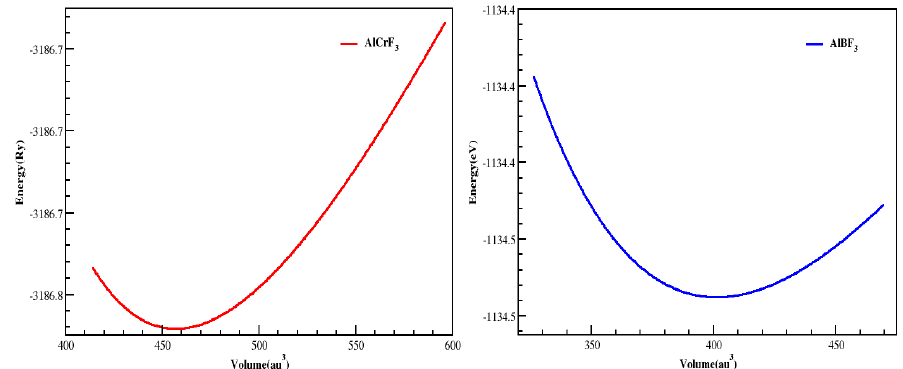
Figure 2. AlMF 3 (M = Cr, B) ‐ based cubic perovskites and their total energy dependency are repre ‐ sented.